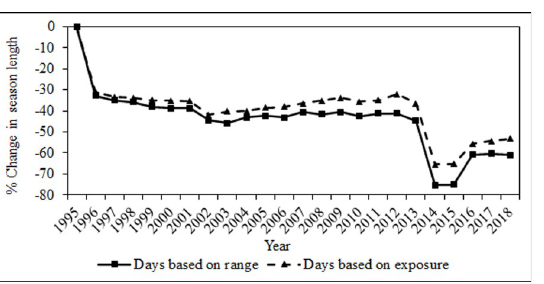
Fig 7. Change over time in season length calculated as total hunt days for greater sage-grouse, 1995–2018. The solid line represents averaged season length within 8 km of all active greater sage-grouse leks within the range of the species, whereas the dashed line represents averaged season length within 8 km of active leks with direct exposure to legal harvest in a given year across the range of greater sage-grouse.